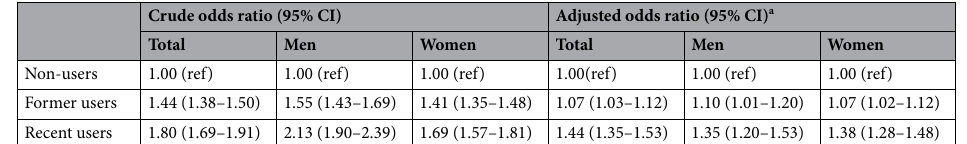
Table 2. Use of Serotonin reuptake inhibitors and the risk of low bone density. a Adjusted for: glucocorticoids, aromatase inhibitors, androgen deprivation therapy, GnRH agonists, anticonvulsants, thiazolidinediones, DMPA, antipsychotics, benzodiazepine, TCA, Estrogen or Estrogen and progesterone combination, household income, CCI, BMI, systolic and diastolic blood pressures, fasting blood glucose level, total cholesterol level, hemoglobin level, urine occult blood, urine protein, AST, ALT, smoking status, frequency of drinking alcohol, and frequency of